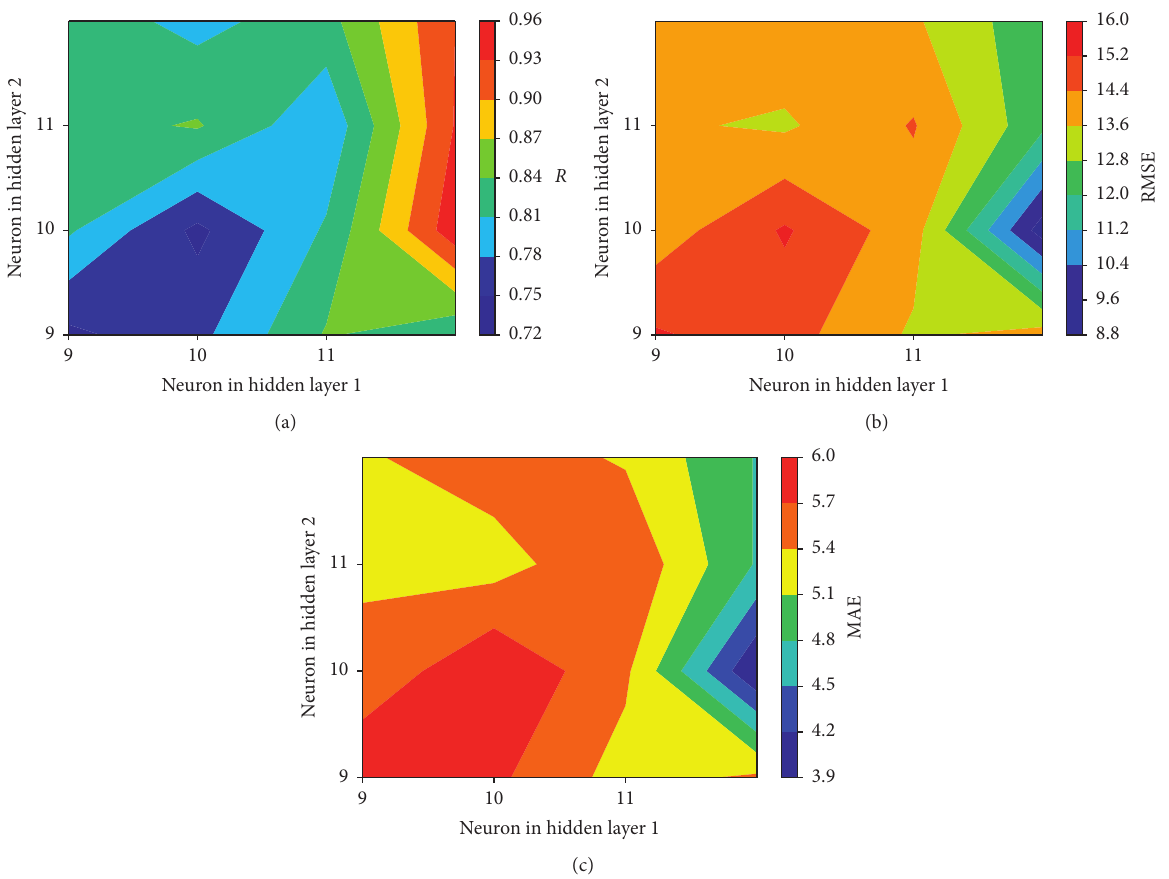
Figure 4: Color map of ANN with 2 hidden layers in function of the neuron in the hidden layer for the training part with respect to (a) values of R , (b) value of RMSE, and (c) value of MAE.